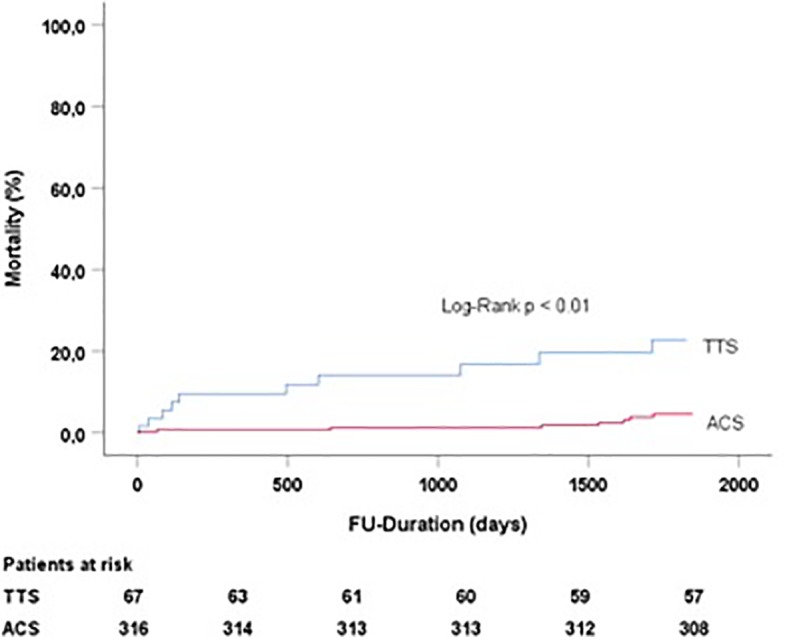
Follow-up duration and mortality in TTS and ACS patients treated with beta-blockers and angiotensin-converting-enzyme inhibitors. TTS, Takotsubo syndrome; ACS, acute coronary syndrome.